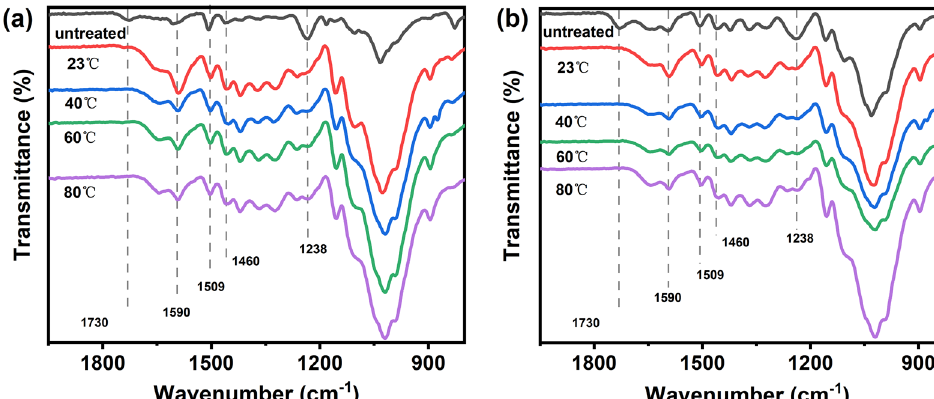
Fig. 3 FTIR spectra of alkali-treated bamboo slivers with different temperatures. a Outer bamboo slivers; b inner bamboo slivers